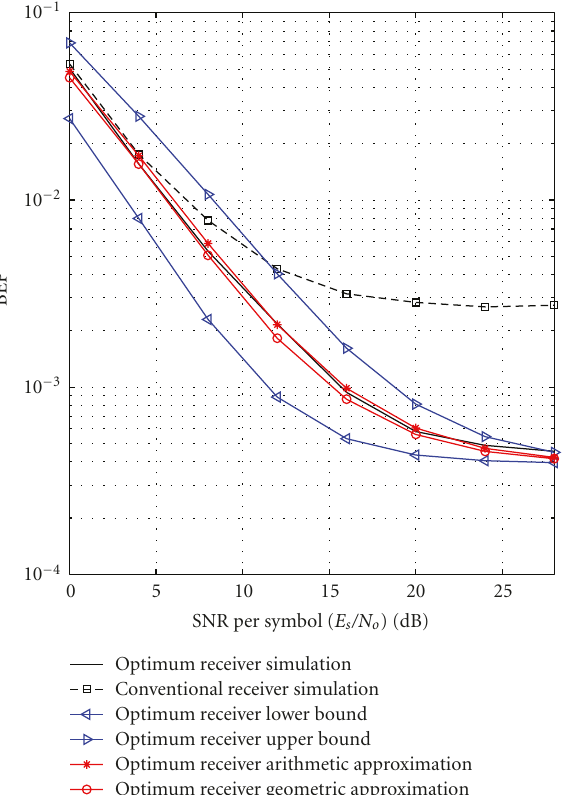
Figure 1: Case 1: BEP results for the conventional and the optimum SBS receivers, 2Tx and 2Rx Alamouti’s code with QPSK modula- tion, f d T b = 0 . 1, channels variances of 0.5 and 5, respectively.